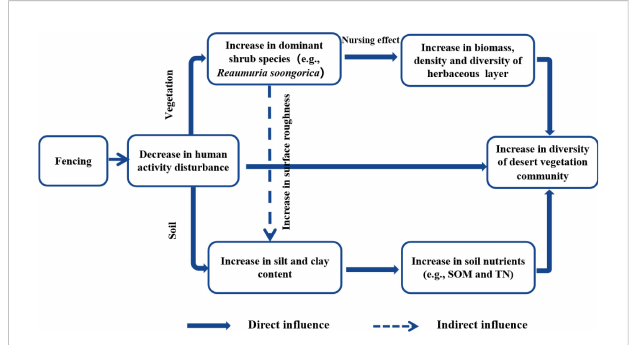
FIGURE 8 The conceptual framework of changes in desert vegetation diversity after fencing.